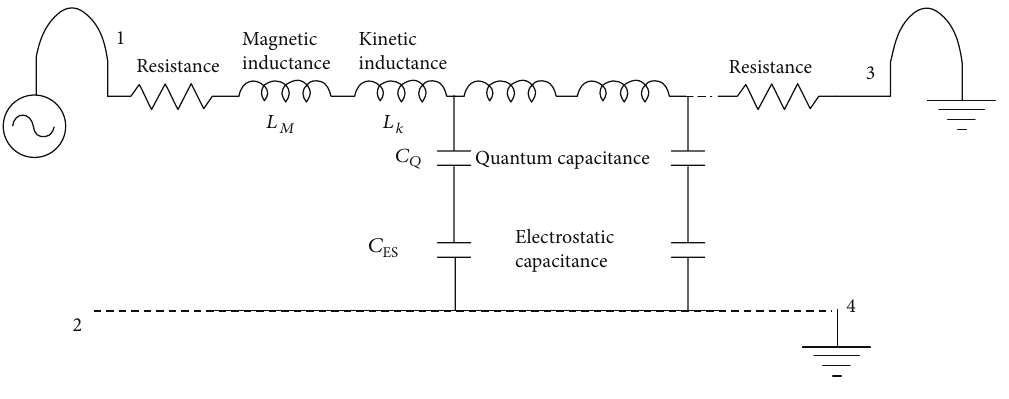
Figure 1: Equivalent circuit model for a CNT interconnect